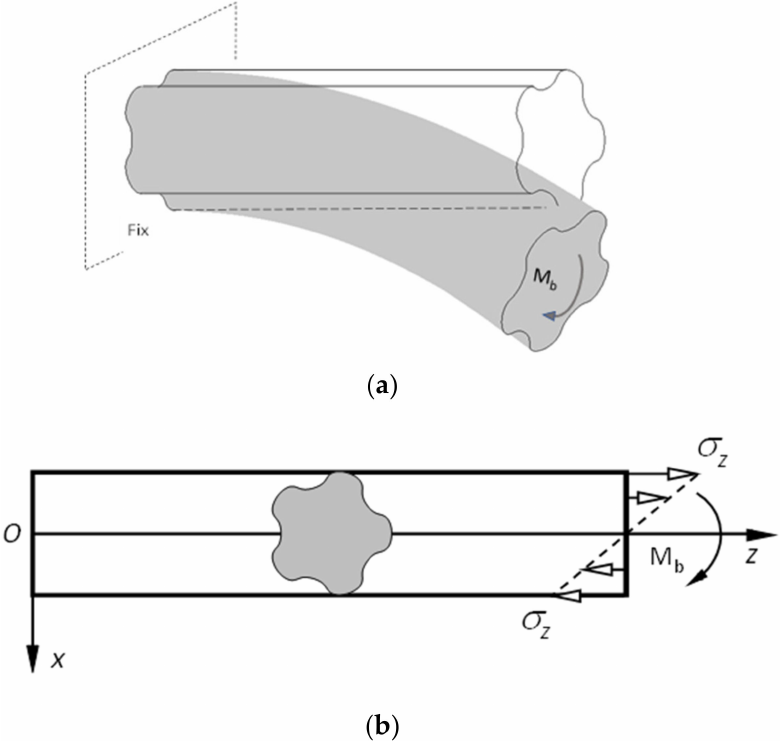
Figure 5. ( a ) Prismatic beam with a noncircular cross-section under pure bending; ( b ) coordinate system used to describe bending